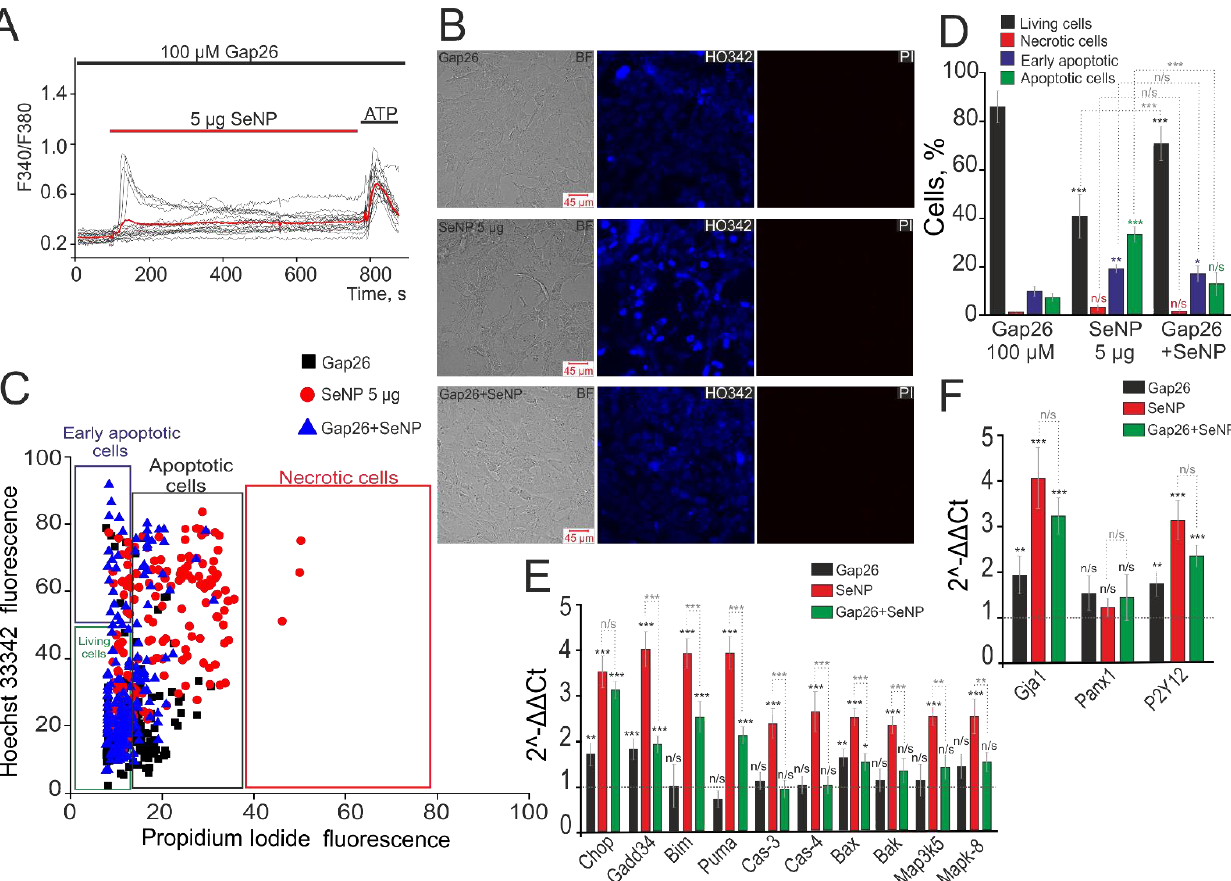
Figure 7. Inhibition of Cx43 suppresses the induction of apoptosis in A-172 cells induced by the application of 5 µg/mL SeNP. ( A ) Suppression of Ca 2+ signals in 87 ± 11% of cells after incubation with 100 μM Gap26 for 30 min and subsequent incubation with 5 μg/mL SeNP for 24 h. ( B ) Identification of cells in the early and late stages of apoptosis or necrosis after incubating with 100 μM Gap26 and 5 μg/mL SeNP separately and together. ( C ) Cytogram demonstrating the viability of A-172 cells. X -axis—the intensity of PI fluorescence; Y -axis—the intensity of Hoechst 33,342 fluorescence. ( D ) The number of cells in the percentage ratio that are in the early (violet column) or late stages (green column) of apoptosis or necrosis (red column) and living cells (black column). ( E , F ) Real-time PCR results showing changes in mRNA expression of the main pro-apoptotic genes ( E ) and genes encoding receptors ( F ) in response to treatment of A-172 cells with 100 µM Gap26 (black columns), 5 μg/mL SeNP (red columns), and Gap26+SeNP (green columns). The horizontal line corresponds to the expression of mRNA of the studied genes in control samples (without some compounds application). The differences are marked with asterisks—* p < 0.05, ** p < 0.01, and *** p < 0.001. n/s—differences insignificant.